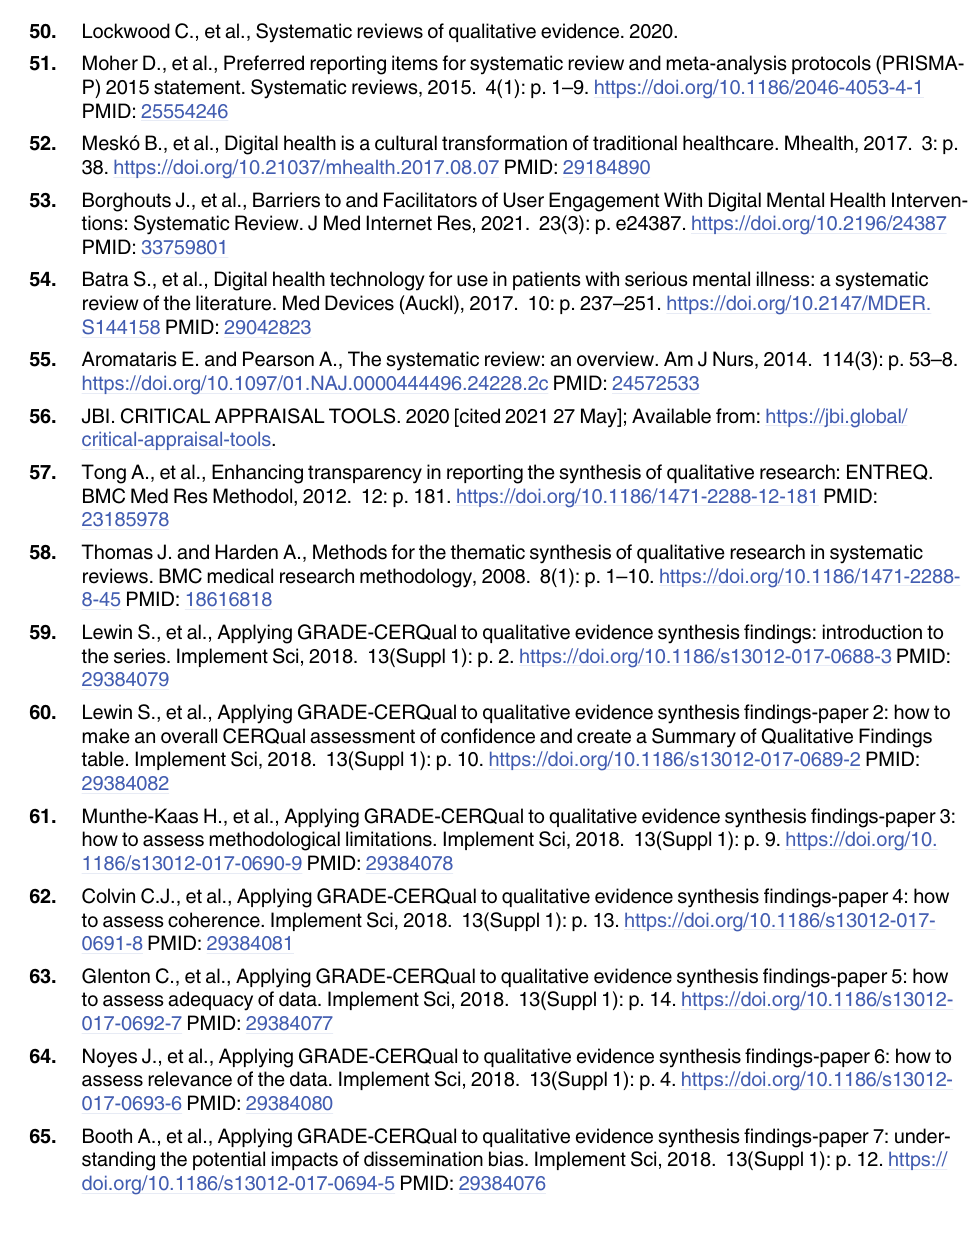
table. Implement Sci, 2018. 13(Suppl1): p. 10. https://doi.org/10.1186/s13012-017-0689-2 PMID: